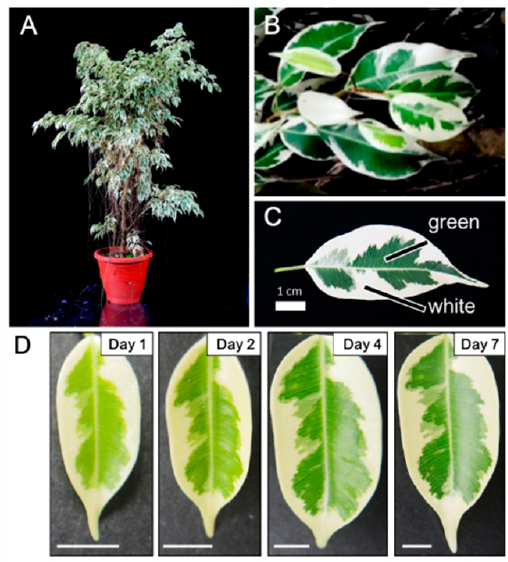
Int. J. Mol. Sci. 2016 , 17 , x Figure 1. Photographs of ( A ) a whole plant, ( B ) a branch, and ( C ) leaf variegated patterns of the milky stripe fig. Black bars in ( C ) indicate the green and white sectors used in the present study. ( D ) Development of one individual leaf. Scale bar in each panel represented 0.5 cm.